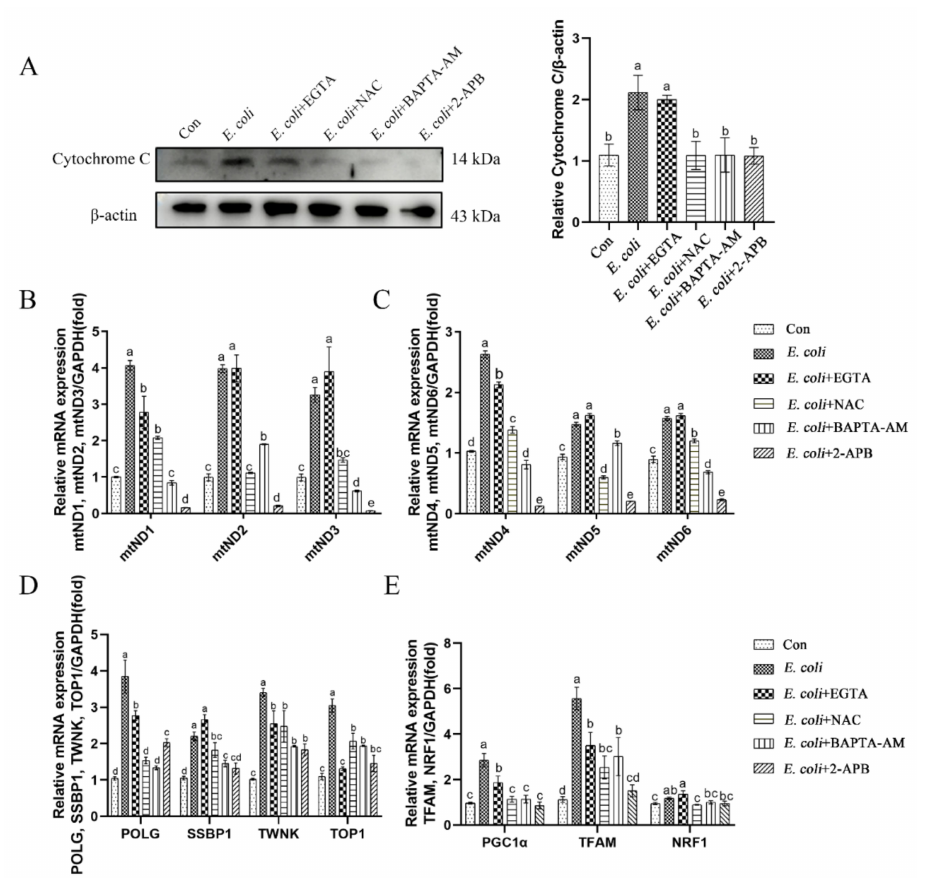
Figure 4. Cytoplasmic Ca 2+ regulates mitochondrial damage during E. coli infection. Primary bEECs were pre-treated with EGTA (5 mM), NAC (8 mM), BAPTA-AM (10 µ M), or 2-APB (50 µ M) before E. coli infection for 6 h. ( A ) Western blot analysis of the expression levels of cytochrome c. ( B ) Real- time quantitative PCR of expression of mitochondrial genome-related genes mtND1 , mtND2 and mtND3 . ( C ) Real-time quantitative PCR analysis of mtND4 , mtND5 , and mtND6 levels. ( D ) Nuclear genes ( POLG , SSBP1 , TWNK , and TOP1 ) that control the replication of mtDNA were detected by real-time quantitative PCR. ( E ) Relative mRNA expression of mitochondrial biogenesis-related genes ( PGC1 α , TFAM , and NRF1 ). The data are means ± SEM of three independent experiments. Bars with different letters indicate significant differences ( p <